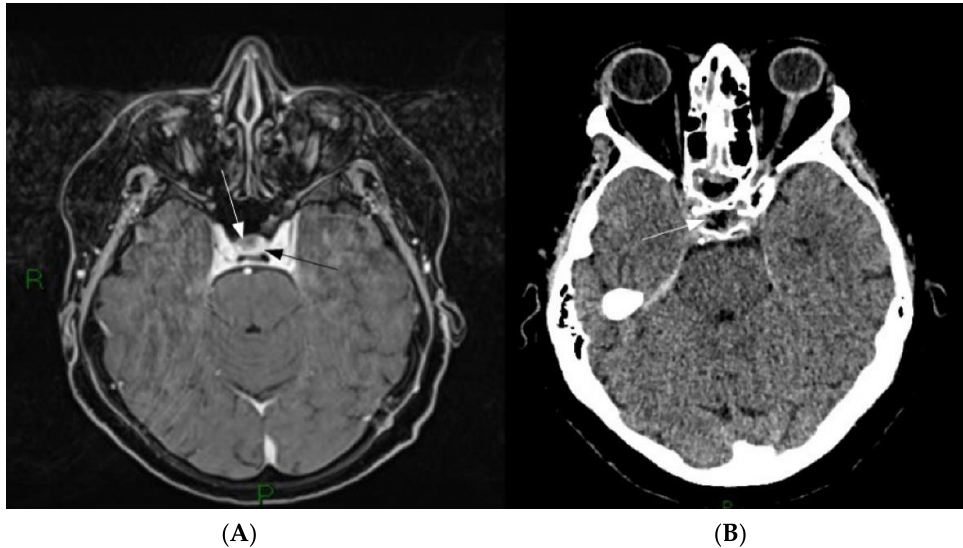
Figure 1. ( A ) Pre-operative Gd-MRI. A small, non-enhancing lesion is present on the right part of the sellar region (white arrow) surrounded by homogenously enhancing normal pituitary parenchyma (black arrow). ( B ) First day postoperative CT scan showing the ablation of the lesion (white arrow).